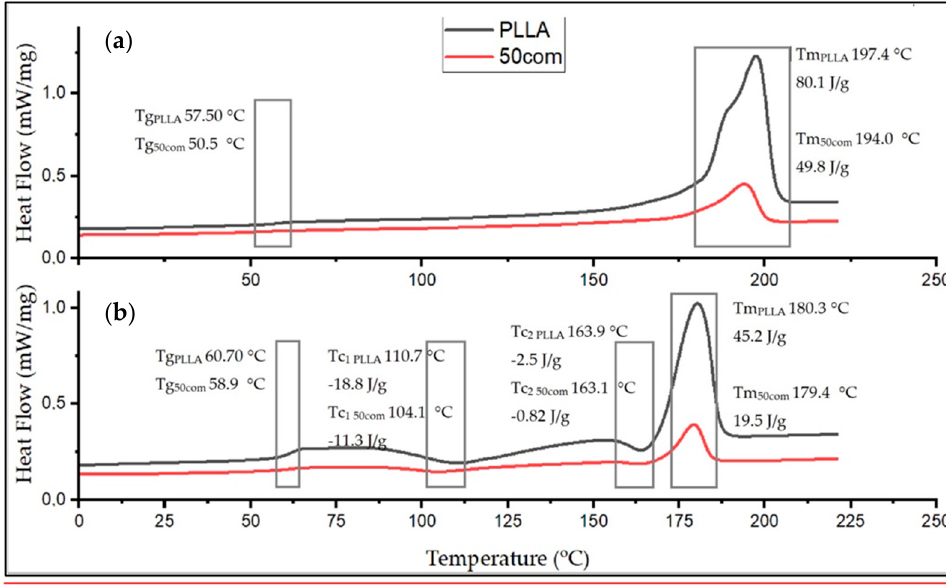
Figure 8. DSC thermograms of PLLA sample and 50com, after first and second heating (( a,b ), respectively).